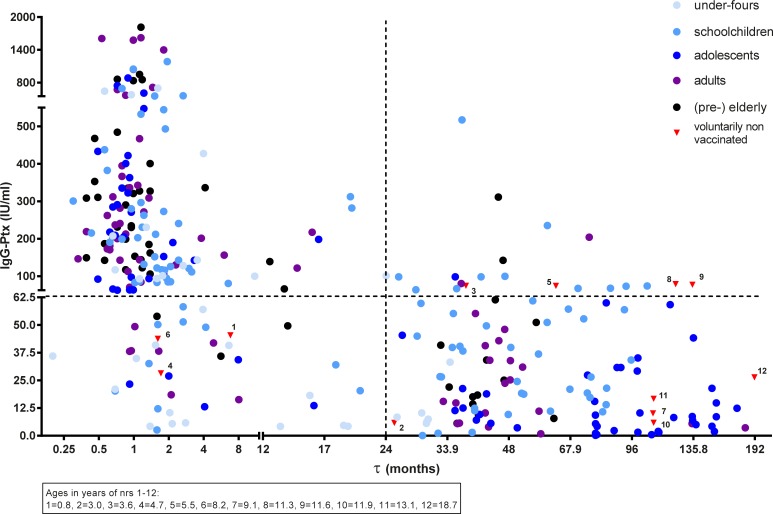
Levels of IgG-Ptx observed in time since last known pertussis antigen exposure in symptomatically infected cases of the SKI study.Cases were stratified according to age and vaccination status as is depicted in Fig 1.